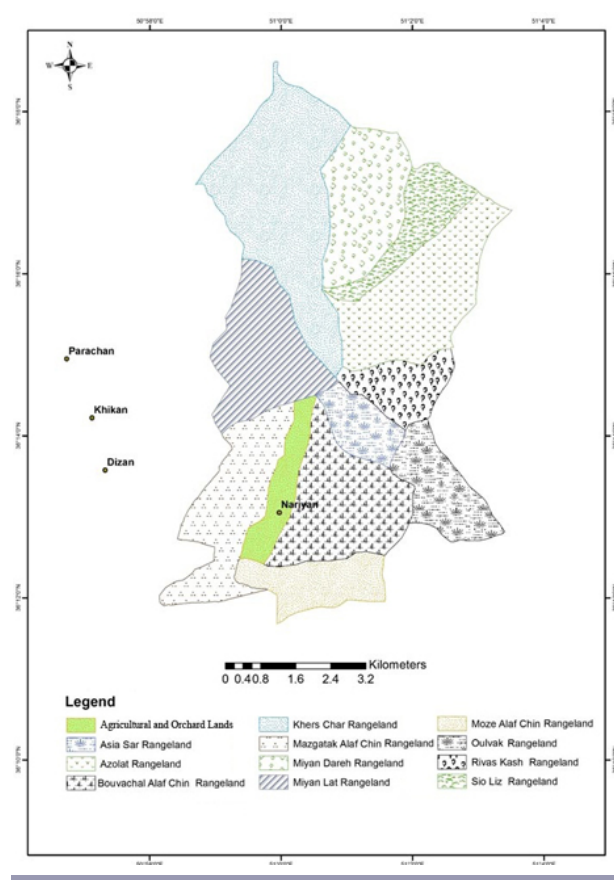
Fig. 2 . Map of the Saman Orfi (traditional boundary) of Nariyan village. Saman Orfi consists of all the common rangelands and the private rangelands of oulvak . The area of Saman Orfi is about 5942 ha. (Source: M. Ghorbani, H. Azarnivand, A. K. Mehrabi, M. Jarari, H. Nayebi, and K. Seeland, personal communication ).